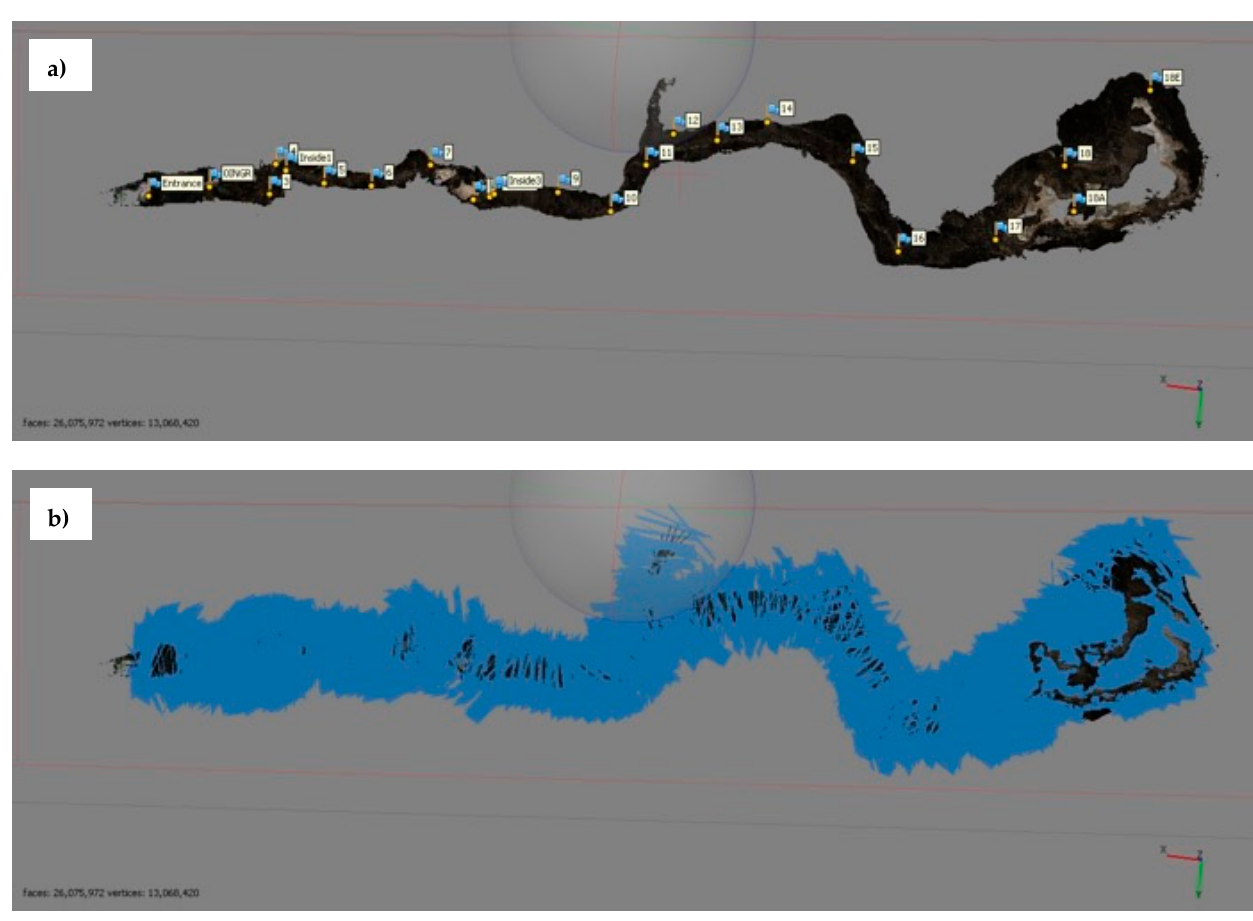
Figure 7. 3D model of the cave with the locations of control points ( a ) and camera shots ( b ). Table 7. SfM co-registering